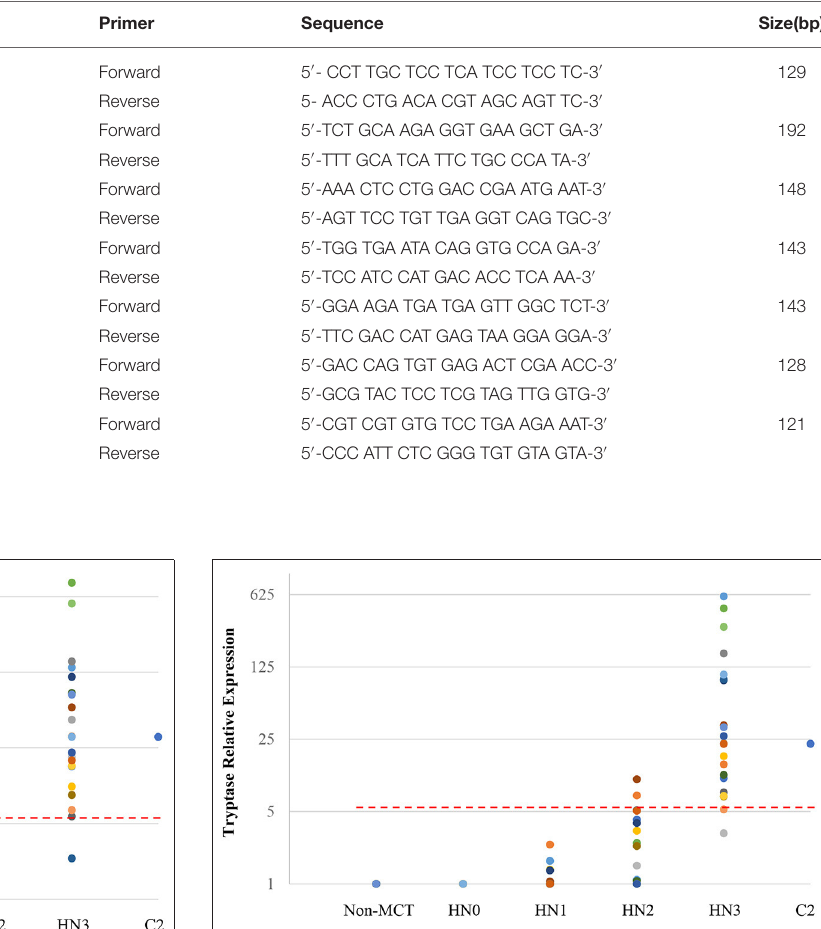
TABLE 1 | Primer sequence used in this study.